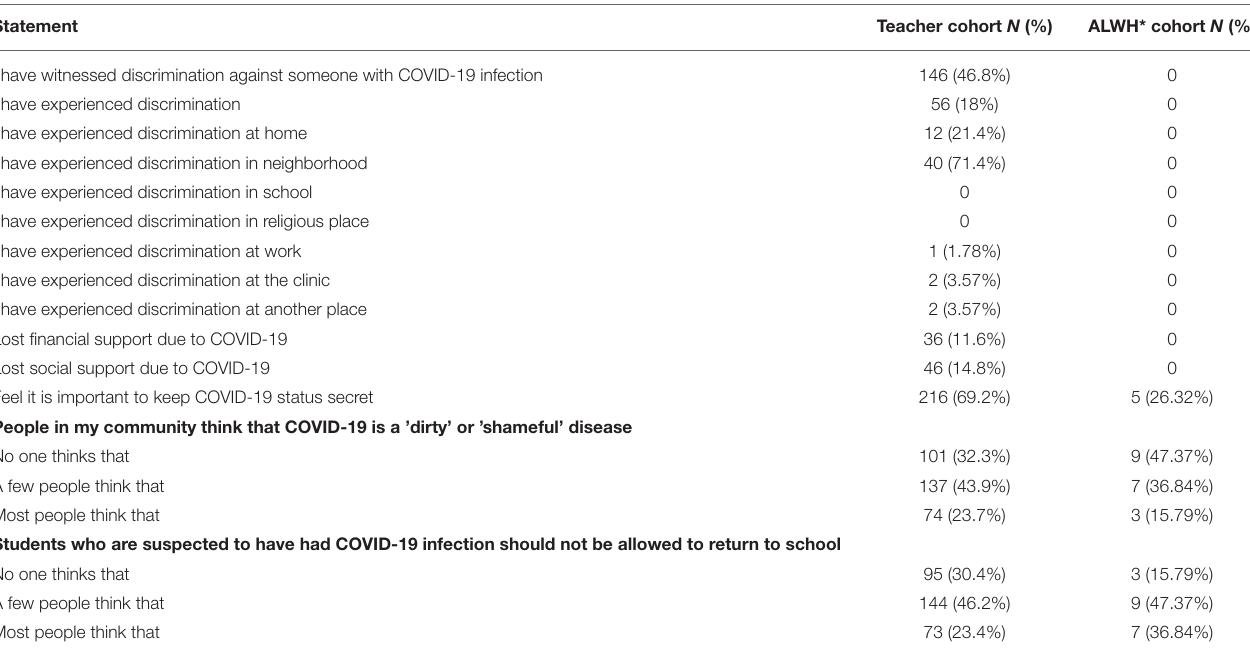
TABLE 1 | COVID-19 stigma survey